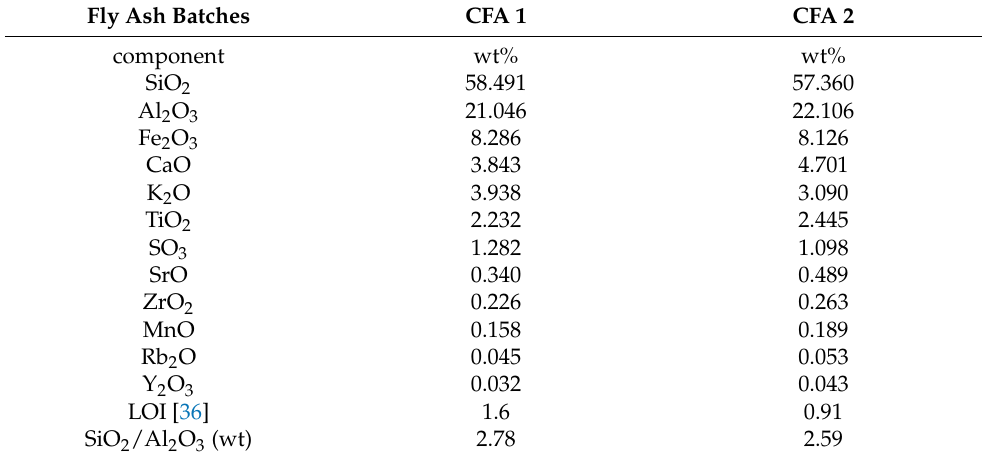
Table 1. Chemical composition of the fly ash as determined by XRF (quantitative